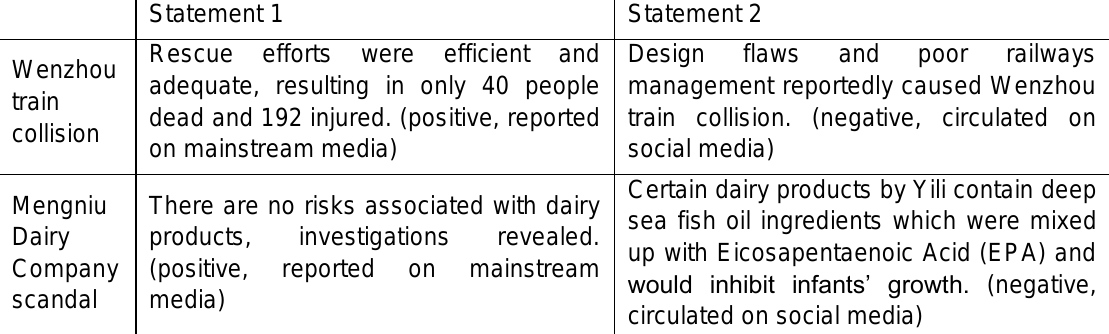
Table 1: Four statements about events reported in mainstream and social